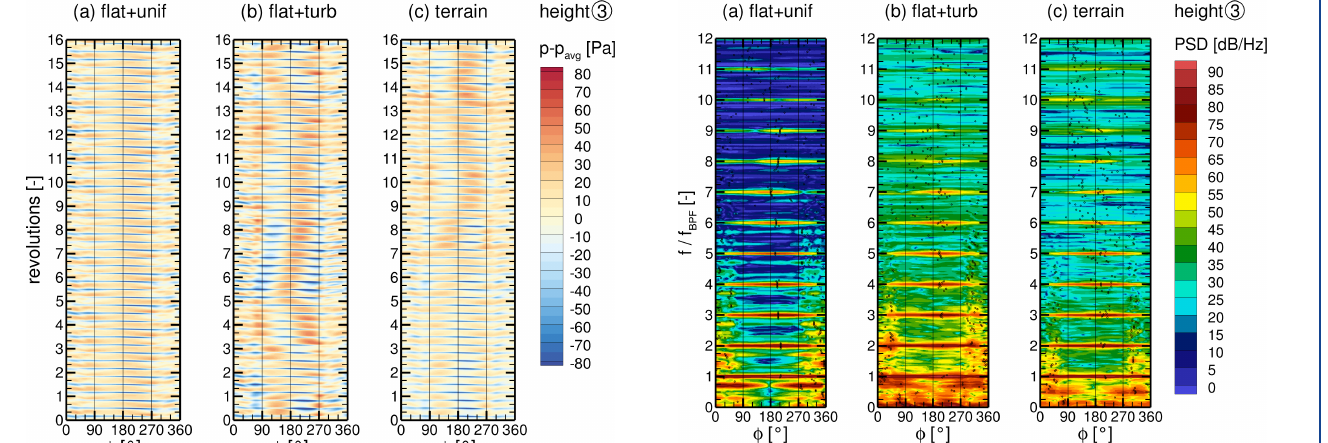
Figure 19. Time series of surface pressure fluctuations p − p avg on a line around the tower at height (3) for all cases (a) – (c) .